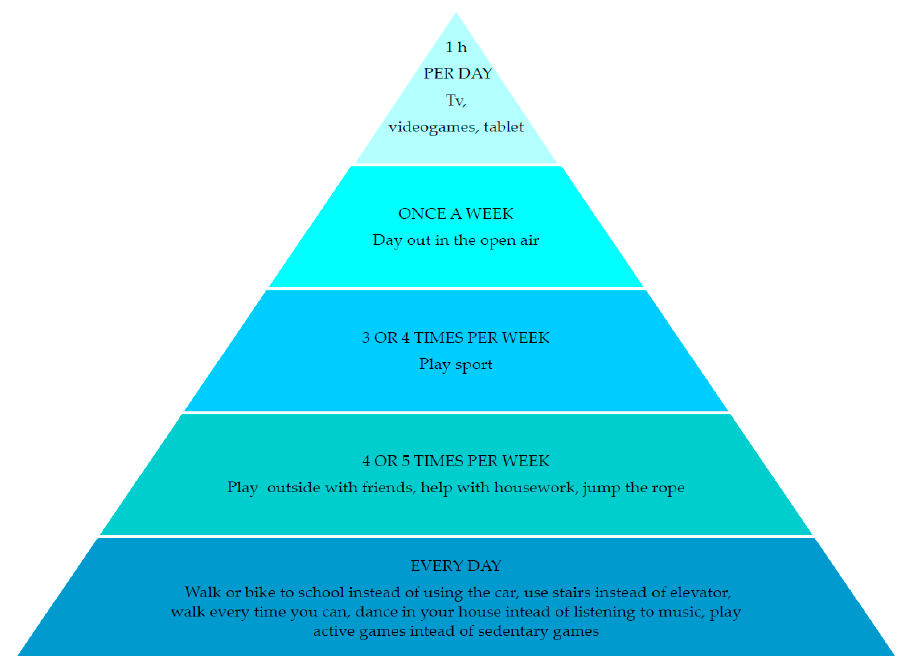
Figure 3. The physical activity pyramid for children, modified from Giovannini et al. [57]. According to the Italian Government Surveillance Project ‘Okkio alla Salute’ between 2008 and 2019, in Italy the prevalence of obesity decreased from 12% to 9.4%, while over- weight prevalence decreased from 23.2% to 20.4% in primary-school children [69]. This is the consequence of numerous interventions promoting healthy lifestyles, such as increas- ing physical activity and improving eating habits in the schools, implemented at regional and local levels. Obesity is frequently associated with multiple metabolic abnormalities that increase patient’s cardiovascular risk: dyslipidemia, insulin resistance and hyperten- sion are the basic components of the metabolic syndrome. According to the International Diabetes Federation, the pediatric metabolic syndrome should be diagnosed in school- aged children (10 years old or more) when abdominal obesity is associated with two or more other clinical features as high blood pressure, elevated triglycerides levels, low HDL-C levels and increased glycemic levels [70]. Genetic, socio-economic and environ- mental factors play a role as metabolic syndrome drivers with unhealthy eating habits at the first place. A diet characterized by high protein content, saturated fats, refined grains, sugar and salty foods and a low consumption of fruits and vegetables, is recognized to worsen metabolic patterns associated with obesity and metabolic syndrome. Dyslipidemia, defined by one or more serum lipids out of range, represents one of the main comorbidities in pediatric obesity and its prevalence among overweight and obese children is about 46–50.4% [71,72]. In particular, in a study that included 139 children, ranging from 8 to 14 years of age, who were overweight or obese according to BMI z- score, detected dyslipidemia patterns were as follows: hypertriglyceridemia (31.9%), low HDL-C (29.7%), high non-HDL-C (15.8%), hypercholesterolemia (11.9%), high LDL-C (10.7%) [71]. BMI z-score showed a positive correlation with triglycerides (TG) and nega- tive with HDL-C levels. The simultaneous presence of obesity and dyslipidemia (espe- cially high TG levels) is associated with the risk of developing cardiovascular events in adulthood [73]. Specifically, TG/HDL-C ratio plays a decisive role and it can be used as a marker for identifying cardio-metabolic risk factors or signs of organ damage when >2.2 [74]. For this reason, it is recommended to screen overweight or obese children for